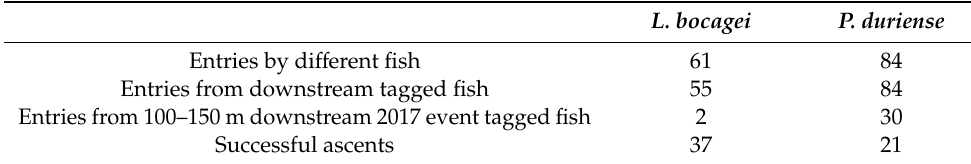
Table 1. Number of fishes recorded at the fishway.